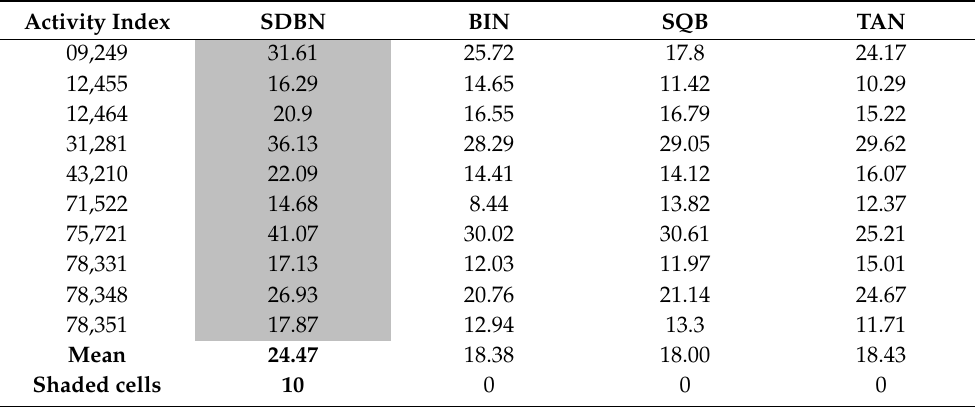
Table 9. Retrieval results of top 5% for MDDR-DS3 dataset.